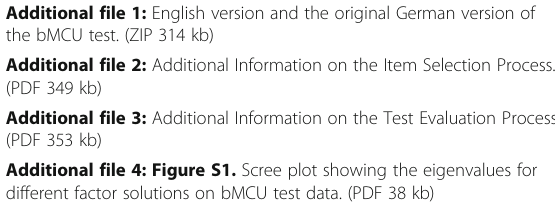
Additional file 4: Figure S1. Scree plot showing the eigenvalues for different factor solutions on bMCU test data. (PDF 38